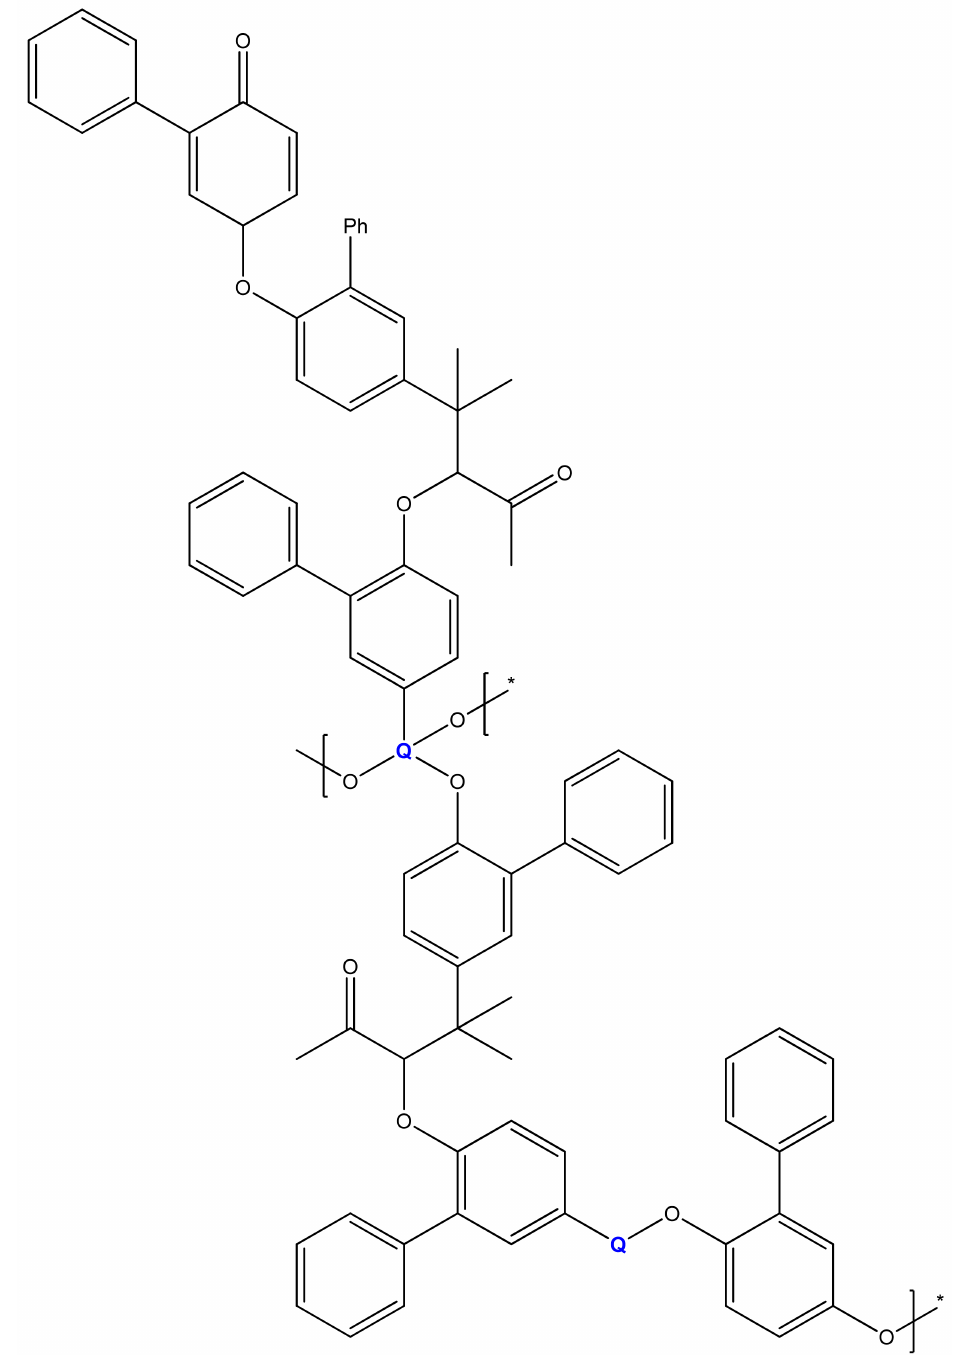
Scheme 1. Schematic representation of the coelectropolymerization reaction of 2-phenylphenol